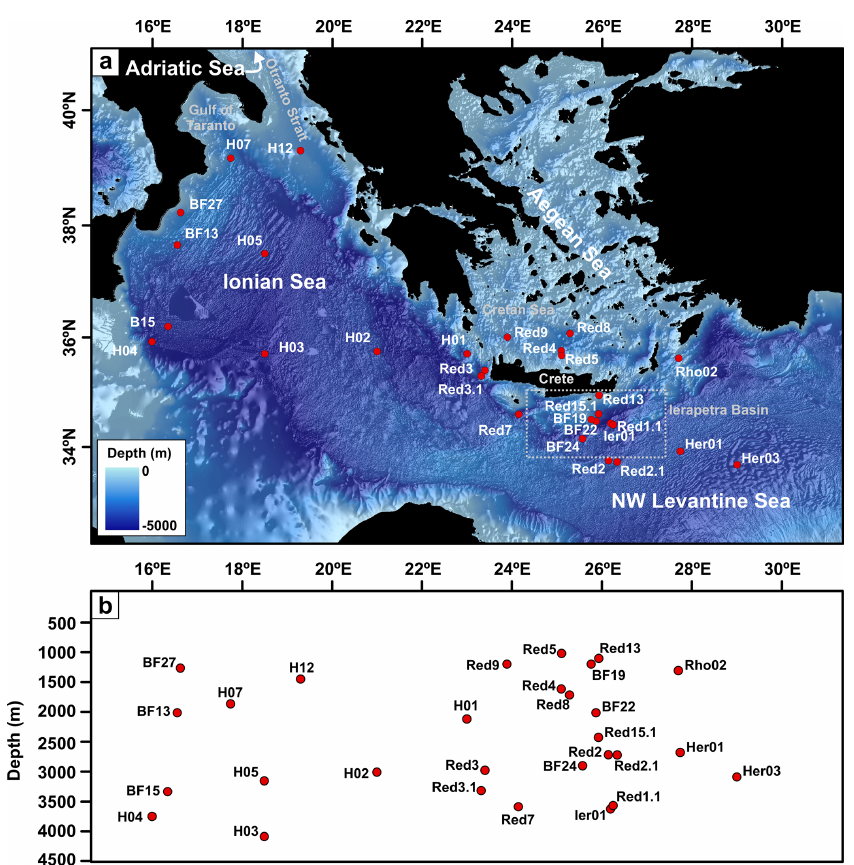
Figure 1. (a) Location of sampling sites across the open eastern Mediterranean Sea (see also Table 1). The map was produced using GEBCO Digital Atlas (IOC, IHO and BODC, 2003). (b) Plot of longitude vs. water depth of sampling